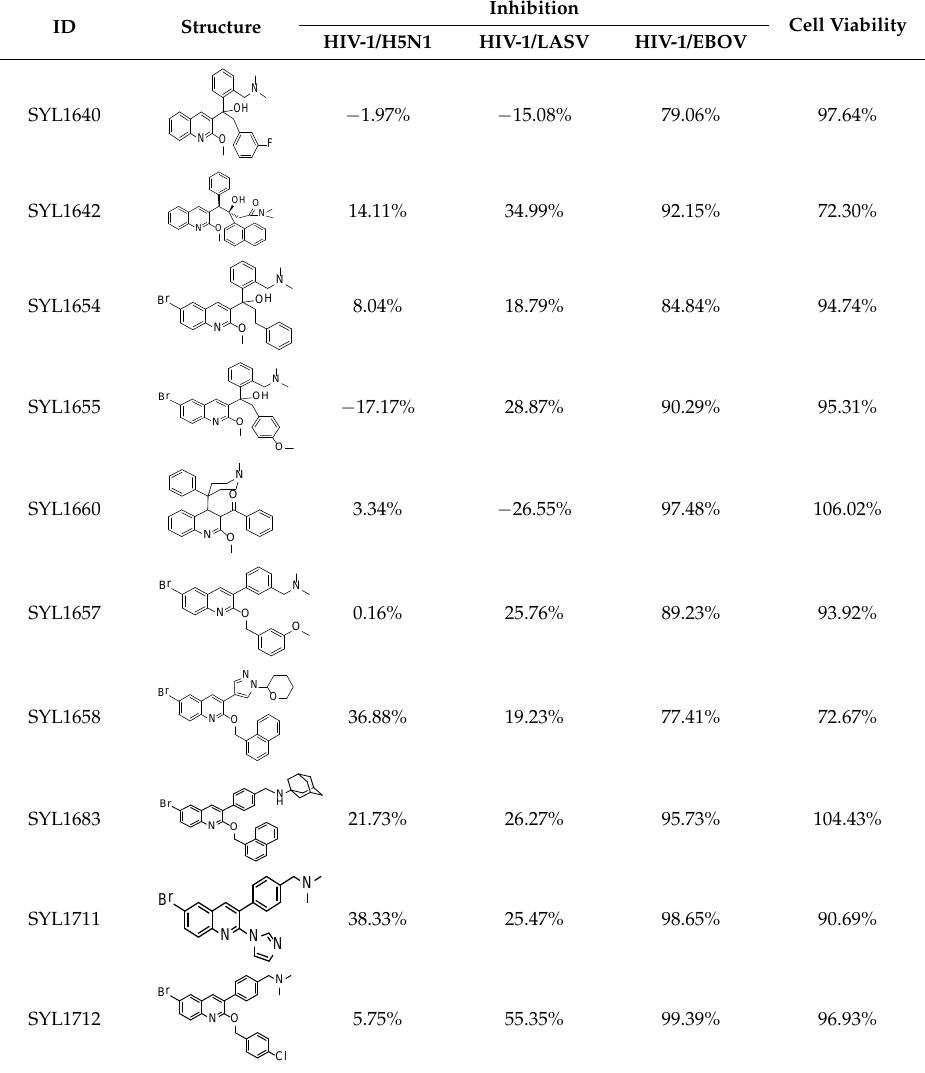
Table 1. List of 10 selected quinoline compounds with specific EBOV entry inhibition at 10 μM.